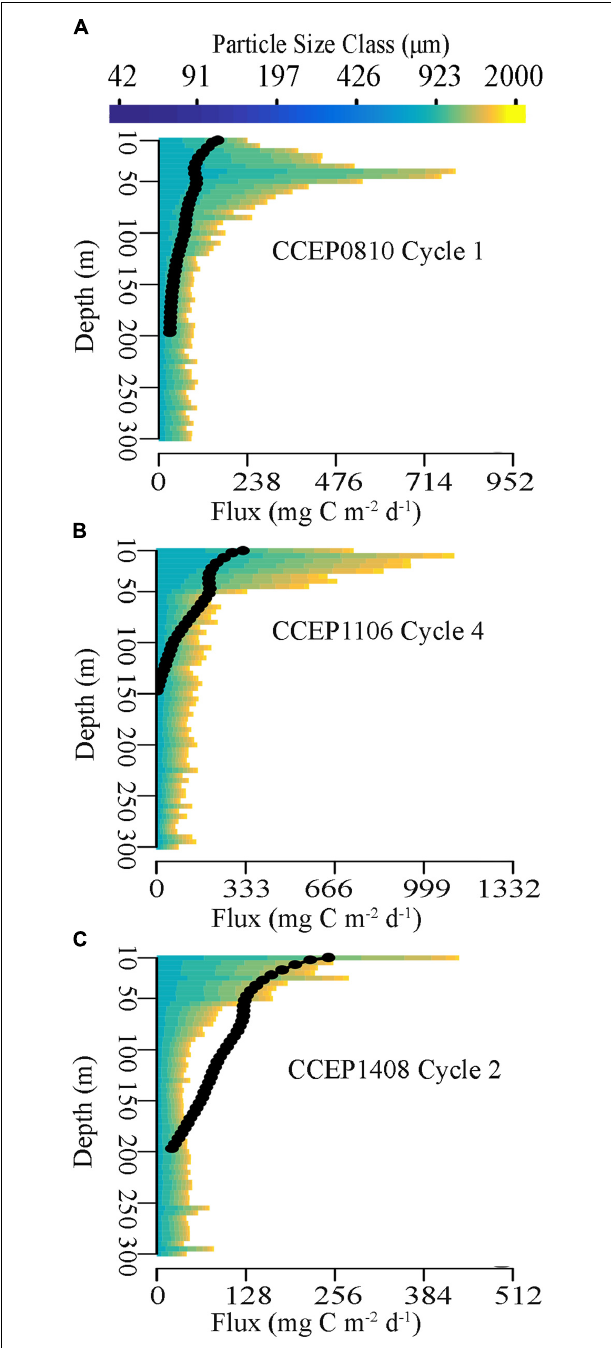
FIGURE 10 | Representative profiles of cycle averaged partial flux due to each particle size bin from 0–300 m depth. Black dots represent Blended Th-ST flux estimates from 0–200 m from cycles (A) P0810-1, (B) P1106-4, and (C) P1408-2.